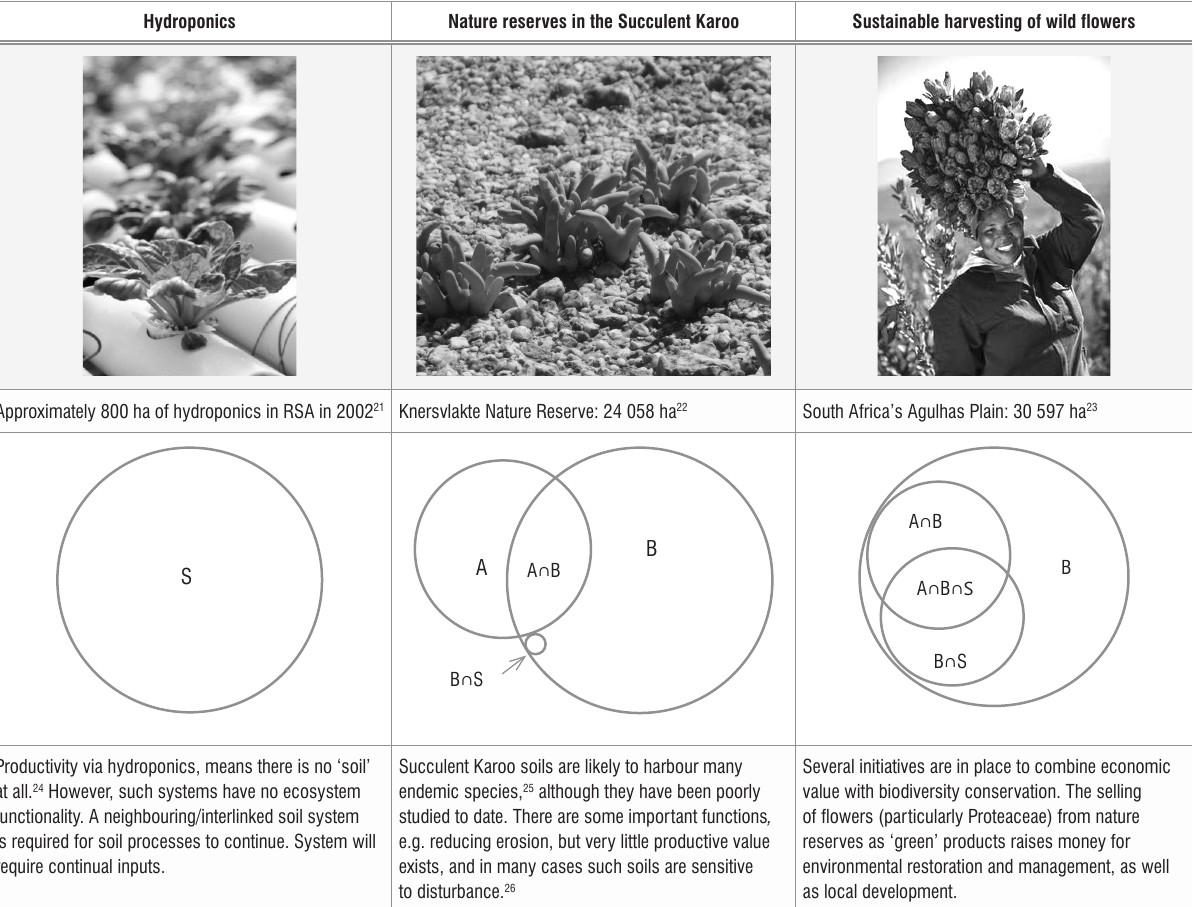
Figure 2: Case studies highlighting how ‘soils’ differ in abiotic, biotic and socio-economic aspects (based on examples from Figure